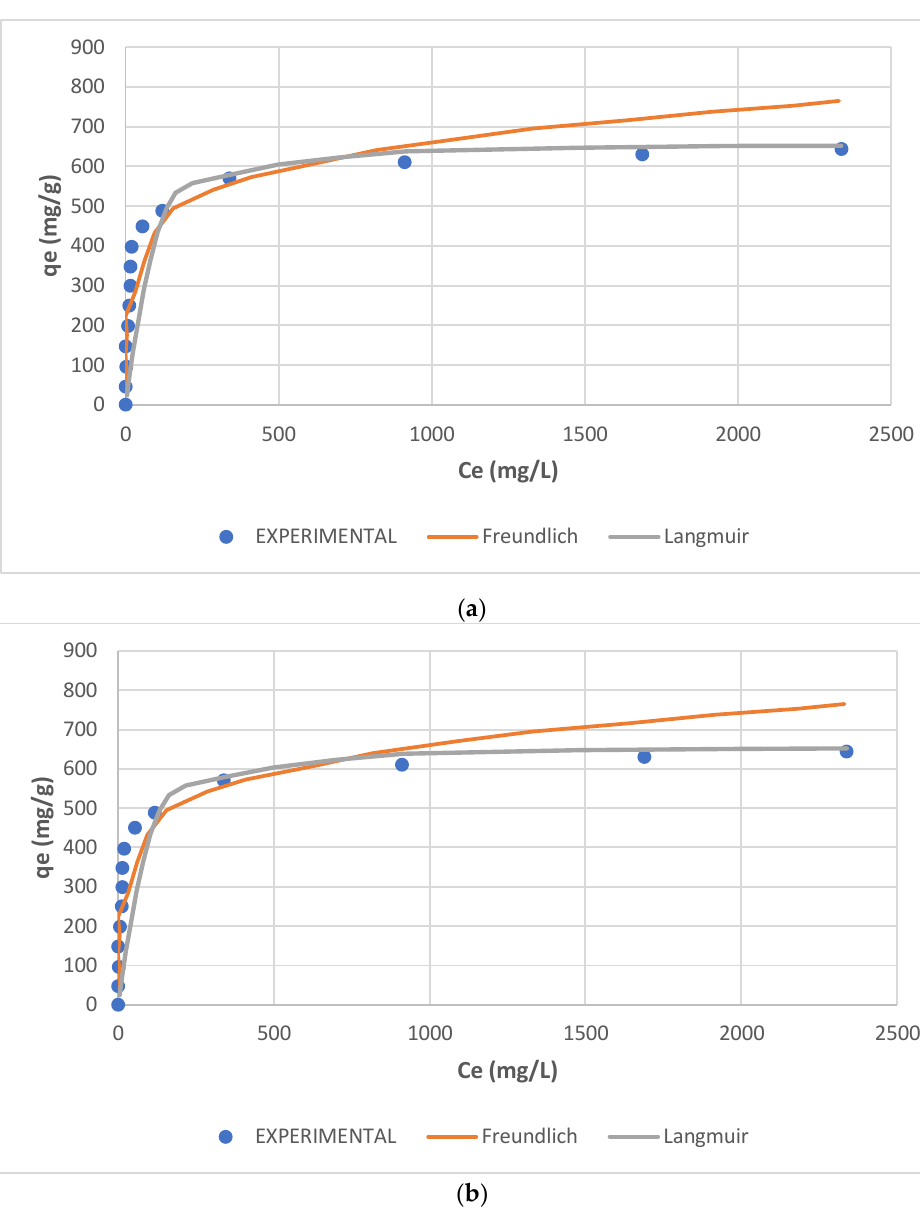
Figure 9. Equilibrium uptake of Direct Yellow RL retention by ( a ) SBR, ( b ) WBR, and the fitting of Freundlich and Langmuir isotherm models.